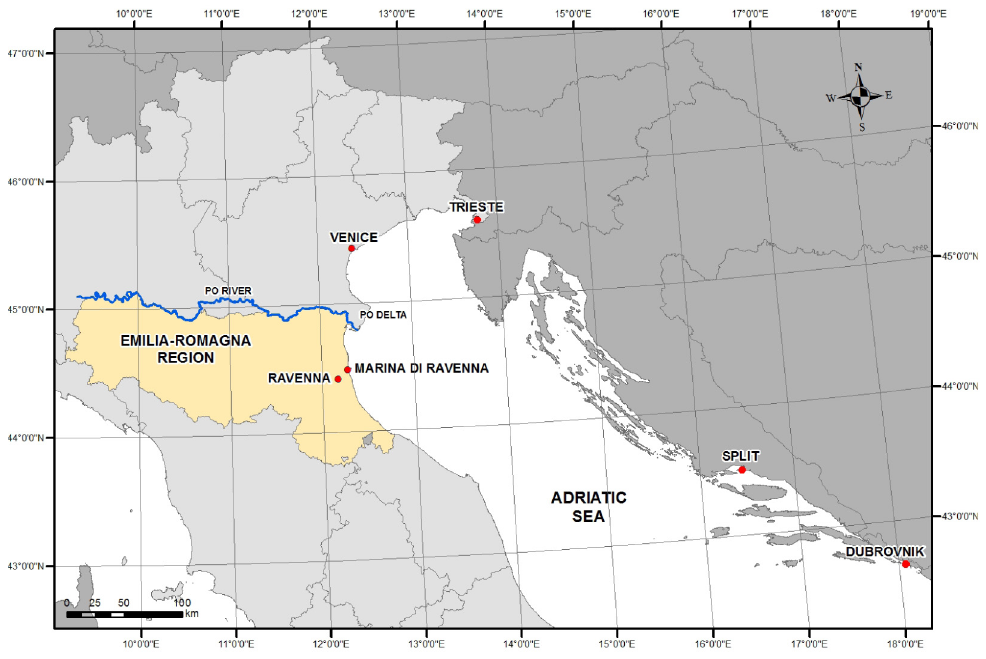
Figure 1. Map of the northern Adriatic Sea and surrounding regions, showing the toponyms of interest for this work. Italy and Emilia- Romagna region are coloured in light grey and yellow, respectively. A blue line marks the path of the Po